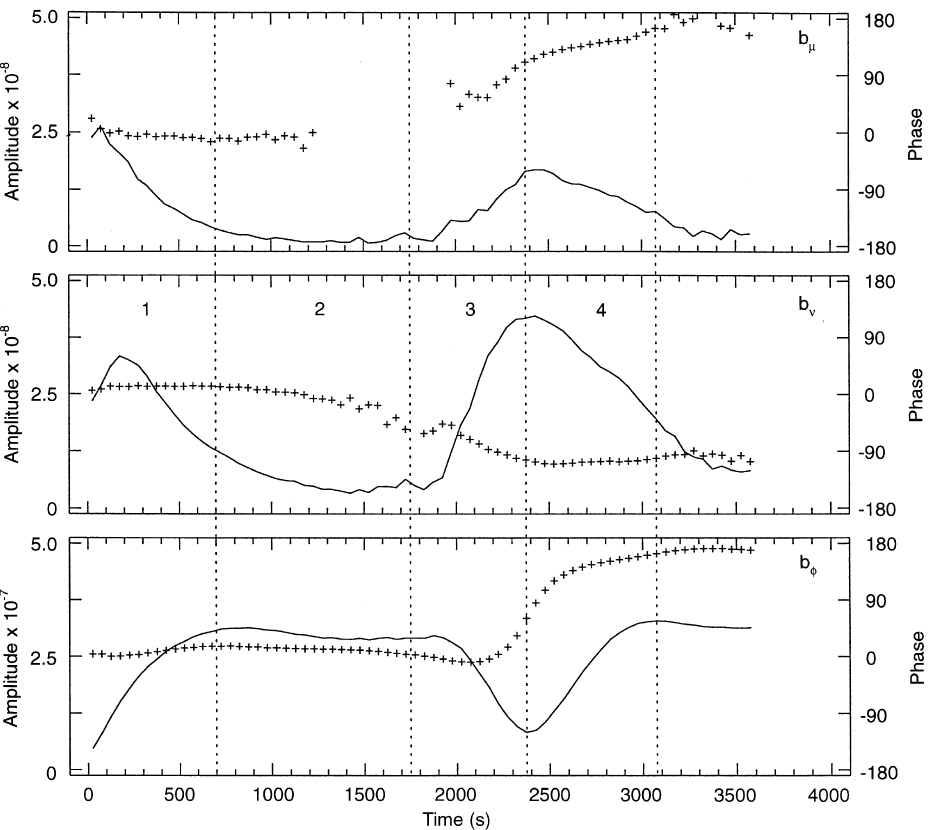
Fig. 5. The temporal develop- ment of amplitude ( solid line ) and phase ( symbols ) of the magnetic field components for a selected frequency band around 20 mHz that includes the resonant fre- quency in the system (high reso-